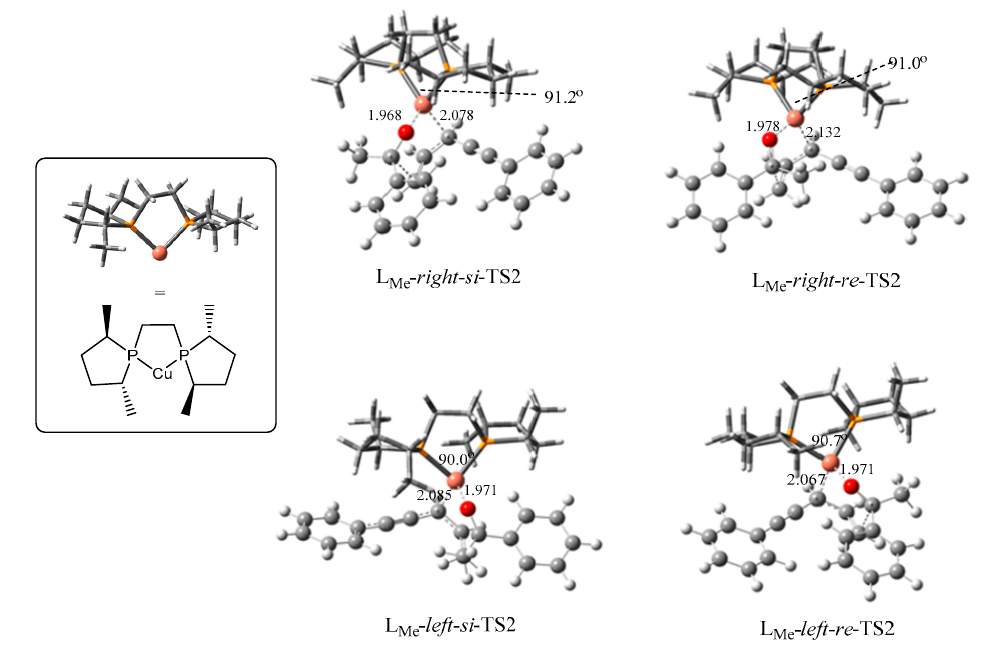
Figure 6. 3D model of stereo-controlling transition states ( TS2 s) at the M06/6-31G(d,p) in the( S,S )-Me-BPE ligand system.